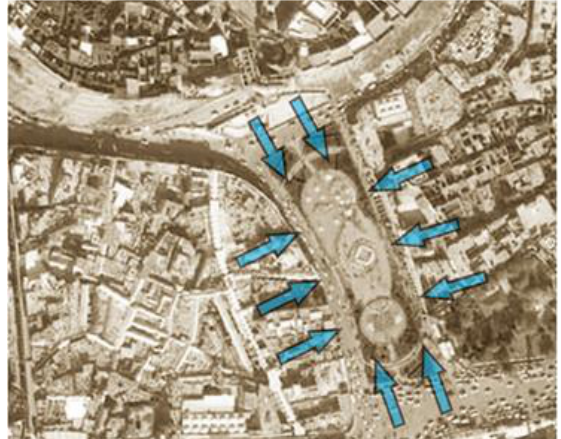
Figure 3. New Centers near the citadel pushing out Source Developed by the